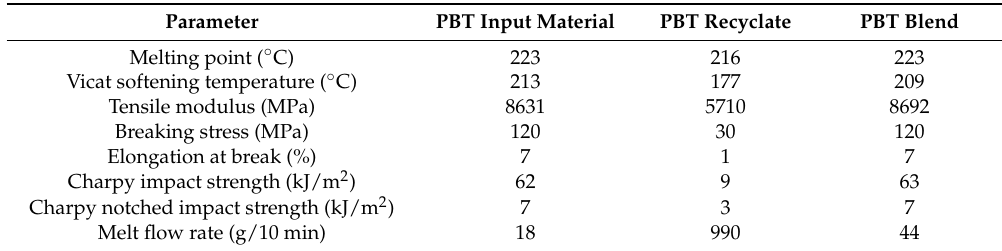
polymer and a mixture